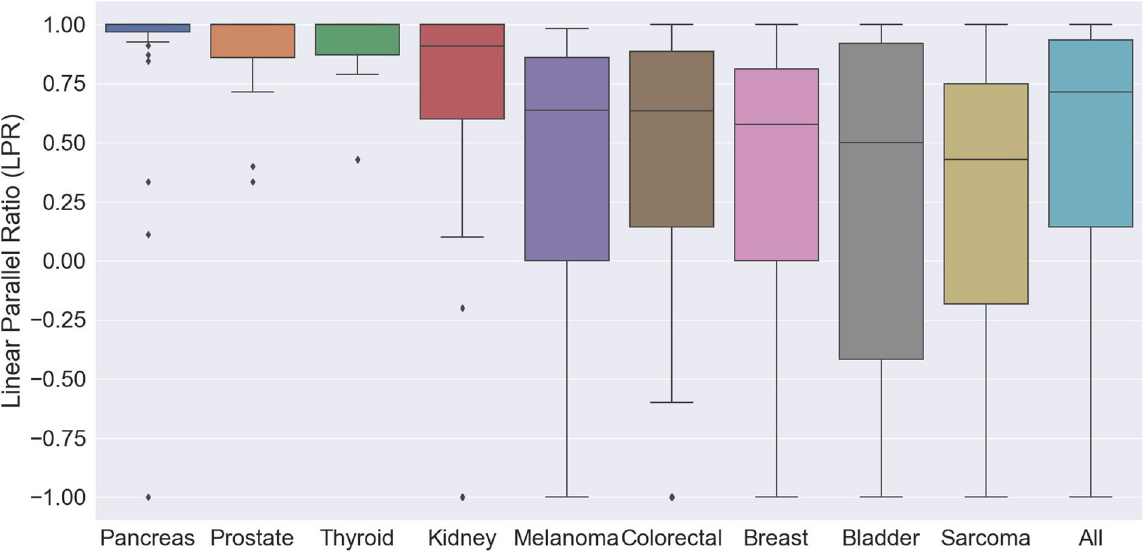
Fig 4. Whisker plot of linear/parallel ratios of nine malignancies including the outliers of each tumor.